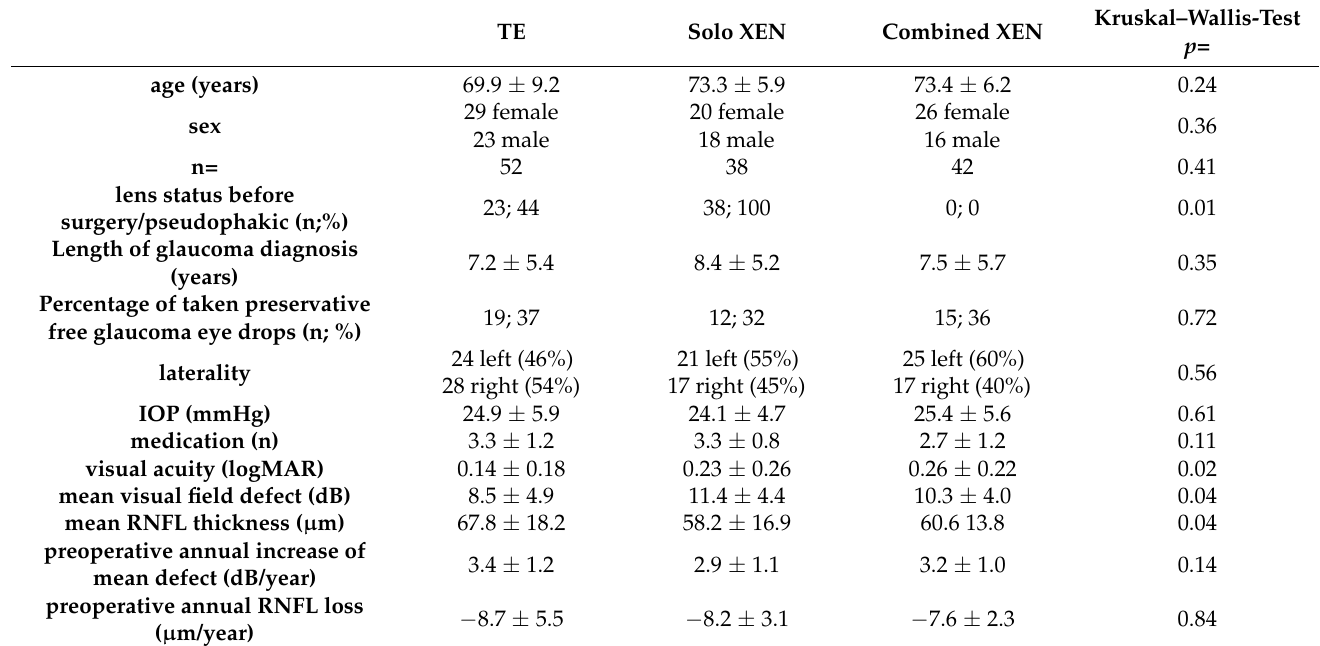
Table 1. Baseline characteristics of eyes included in the three treatment groups treated with either TE, solo XEN or combined XEN. IOP: intraocular pressure; RNFL: retinal nerve fiber layer; TE: